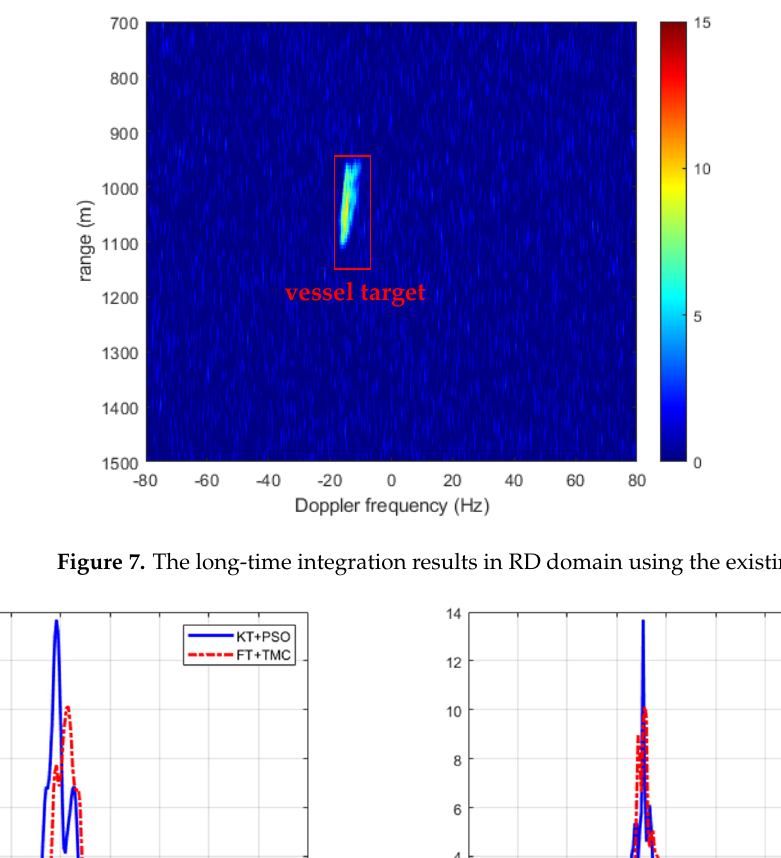
Figure 9. Detection probability of the proposed method and the existing method.